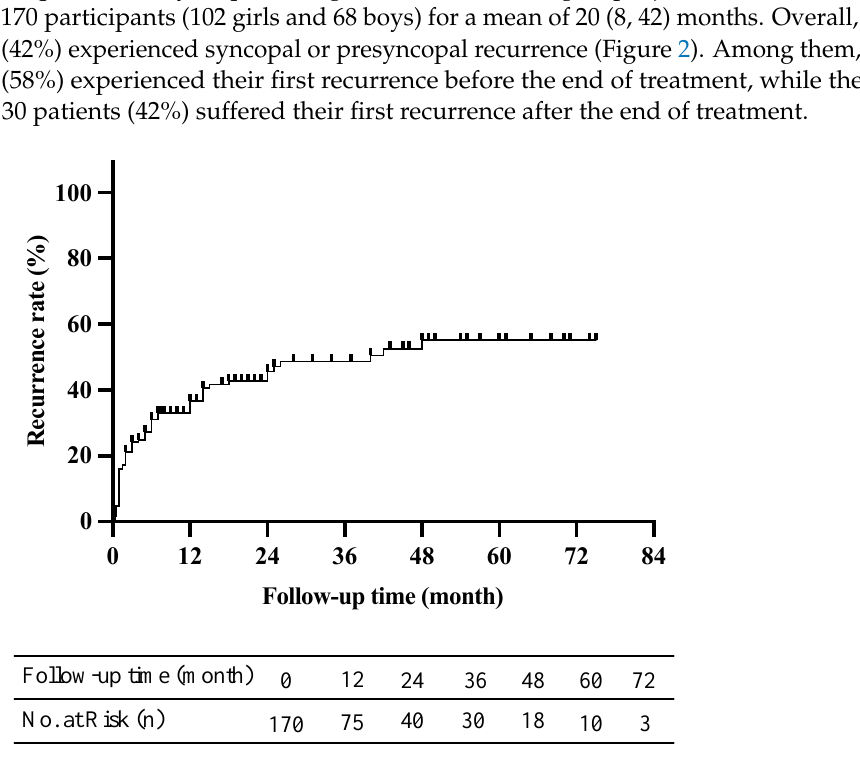
Figure 2. Kaplan–Meier curve analysis of children with vasovagal syncope during follow-up ( n = 170). The mean follow-up time was 20 (8, 42) months, and 72 children (42%) experienced syncopal or presyncopal recurrence.